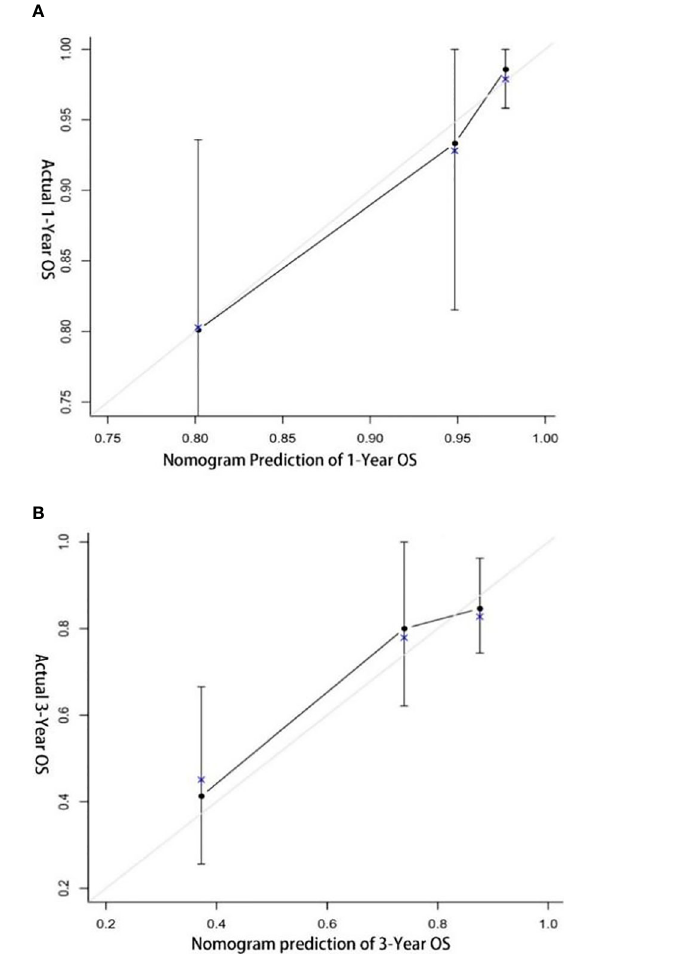
FIGURE 4 | Calibration plot of nomogram. (A) 1-year overall survival; (B) 3-year overall